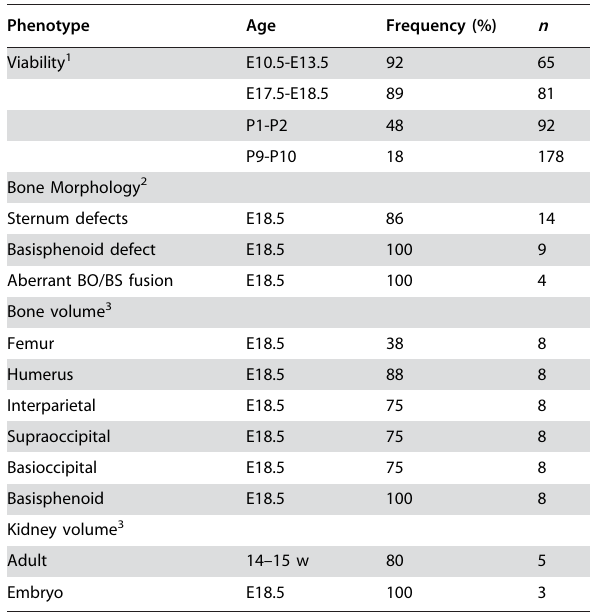
Table 4. Penetrance of selected phenotypes in the Sulf1 2 / 2